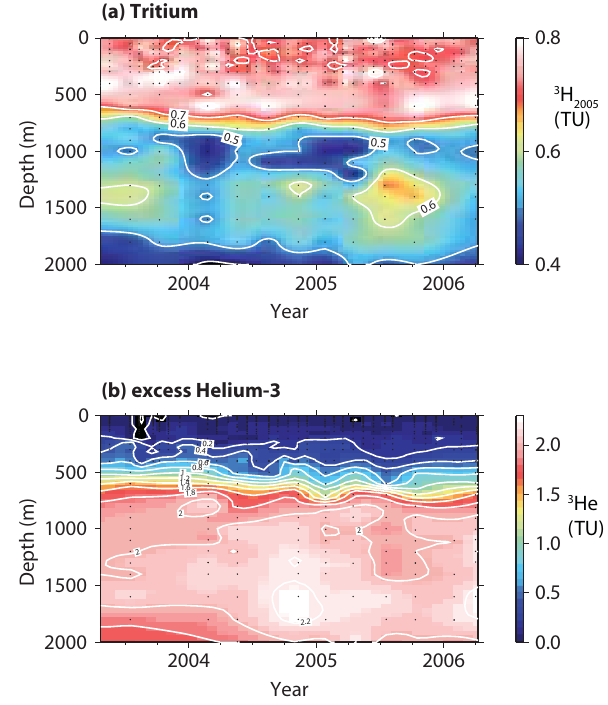
Fig. 2. Three year time-series of (a) tritium and (b) excess 3 He from the Sargasso Sea. All tritium data has been decay-corrected to a reference date of 1 January 2005. Black dots reflect locations of data. Contours lines are drawn at every 0.1 TU for 3 H 2005 and every 0.2 TU for 3